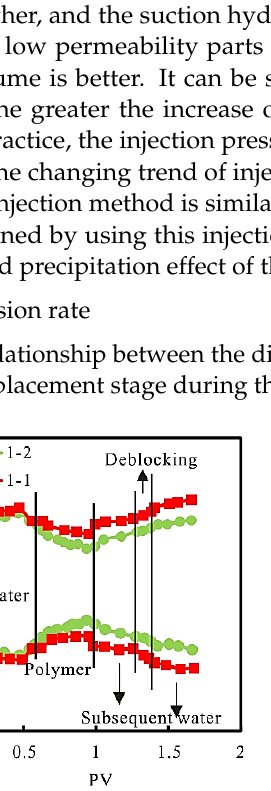
Figure 5. Relationship between diversion rate and PV at production end.